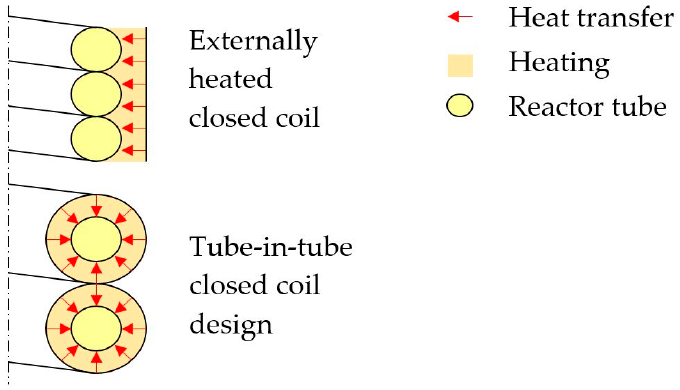
Figure 1. Simplified cross section of the externally heated closed helical coil design ( top ) and the tube-in-tube closed helical coil design proposed here ( bottom ).